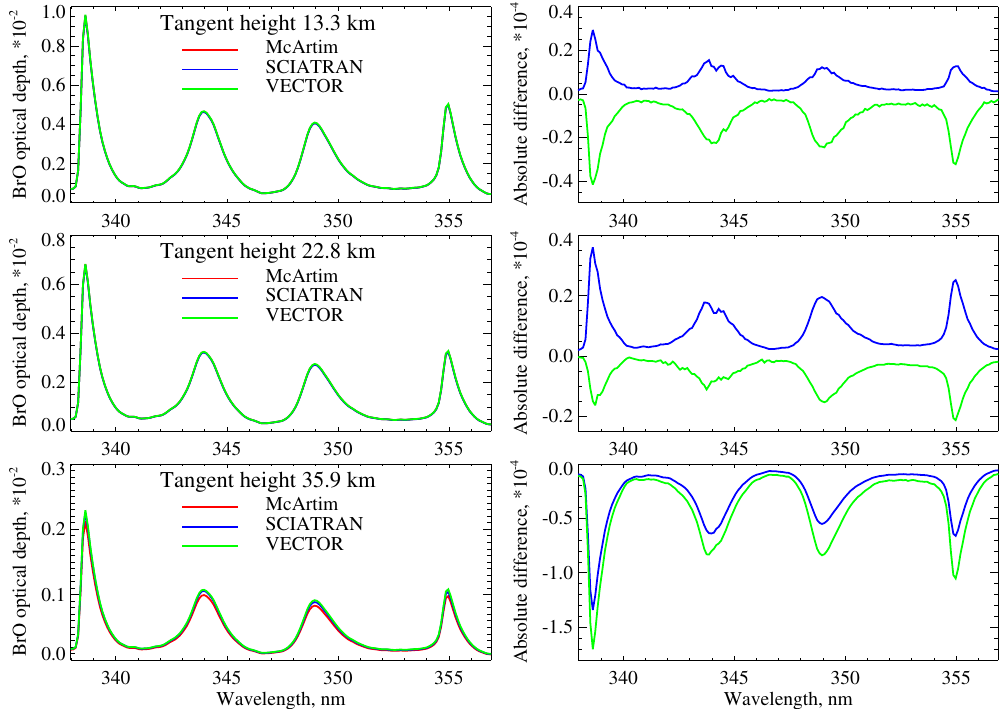
Fig. 8. Optical depths of BrO simulated using different radiative transfer models (left panels) and absolute differences in simulated optical depths with respect to McArtim results (right panels) at different tangent heights. The simulations are performed for an observation geometry typical for high-latitude spring